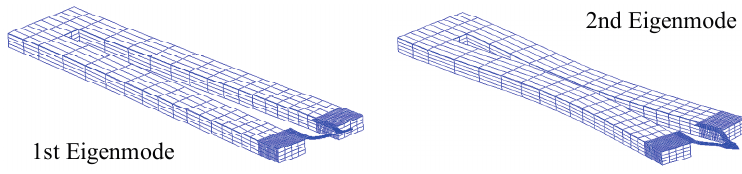
Figure 3. The vibration analysis of the Akiyama